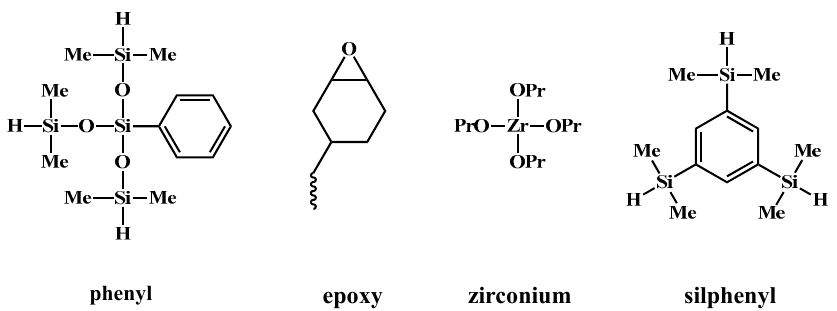
Figure 3. Cross-linker units such as phenyl [9], epoxy [8], zirconium [10], and silphenyl (this work) for the fabrication of polysiloxane hybrimers.